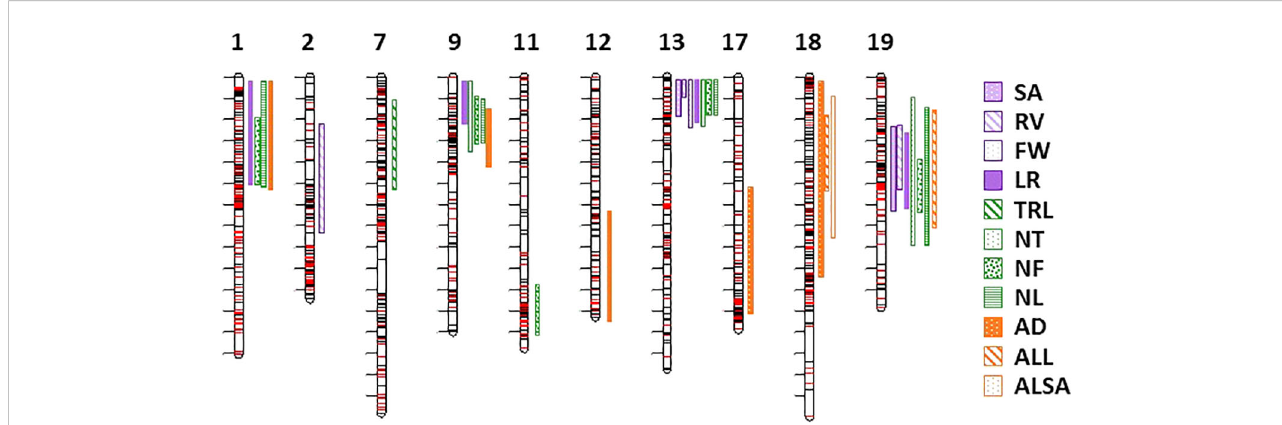
FIGURE 4 Chromosomal location of 31 QTL for eleven RSA traits. Chromosome number is at the top of the image. Legend on right of image identi fi es RSA traits with QTL (surface area (SA); root volume (RV); fresh weight (FW); total root length (TRL); longest root (LR); number of tips, forks, and links (NT, NF, NL); and average diameter, link length, and link surface area (AD, ALL, ALSA). Length of the band identi fi es the con fi dence interval.